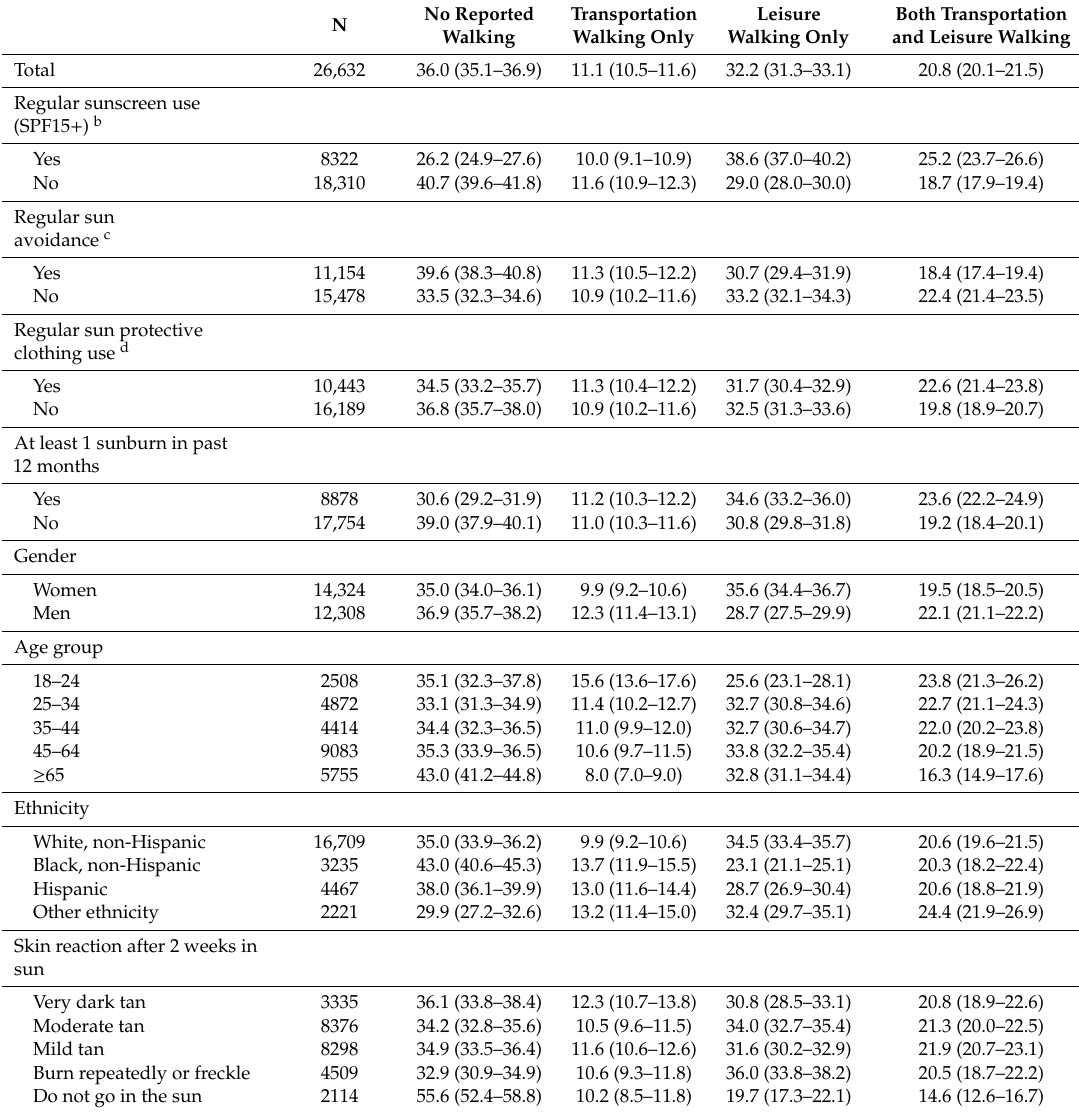
Table 1. Weighted unadjusted prevalence (%) and 95% confidence intervals in exclusive walking categories a (rows sum to 100%) for U.S. adults by selected characteristics, National Health Interview Survey,